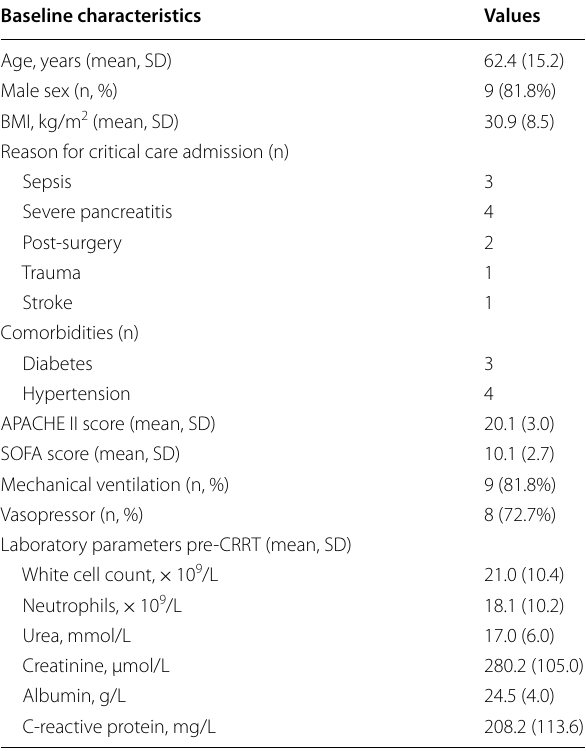
APACHE II Acute Physiologic and Chronic Health Evaluation II, BMI body mass index, CRRT continuous renal replacement therapy, SD standard deviation, SOFA Sequential Organ Failure Assessment